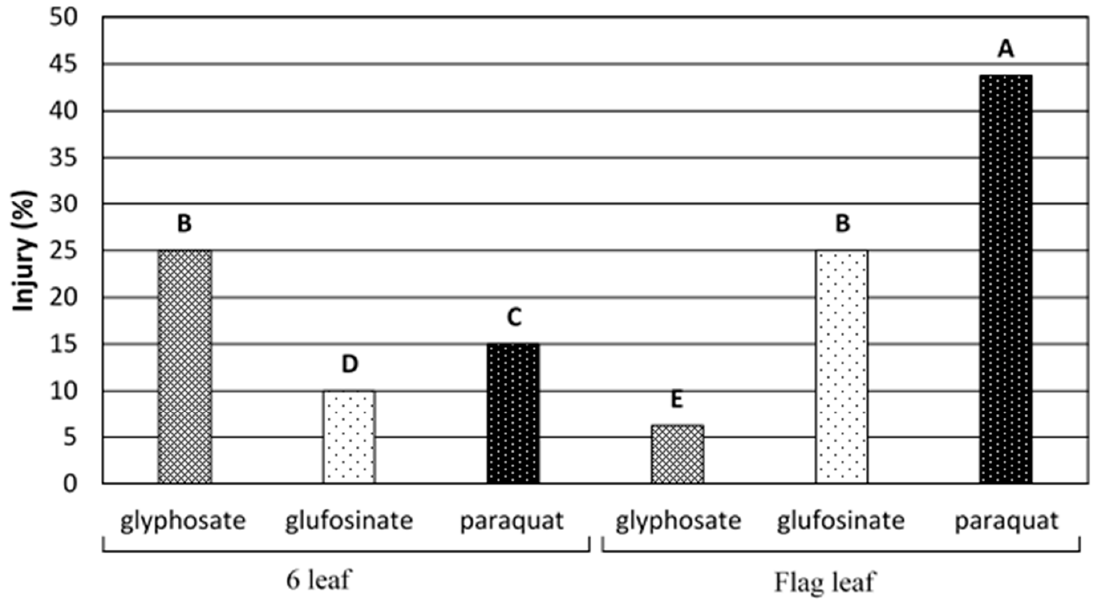
Figure 7. Grain sorghum injury from a simulated drift at 14 DAA as affected by the interaction of herbicides and application timing in 2018. Same letters on bars indicate no significant differences at p < 0.05, according to Fisher’s least significant difference test.